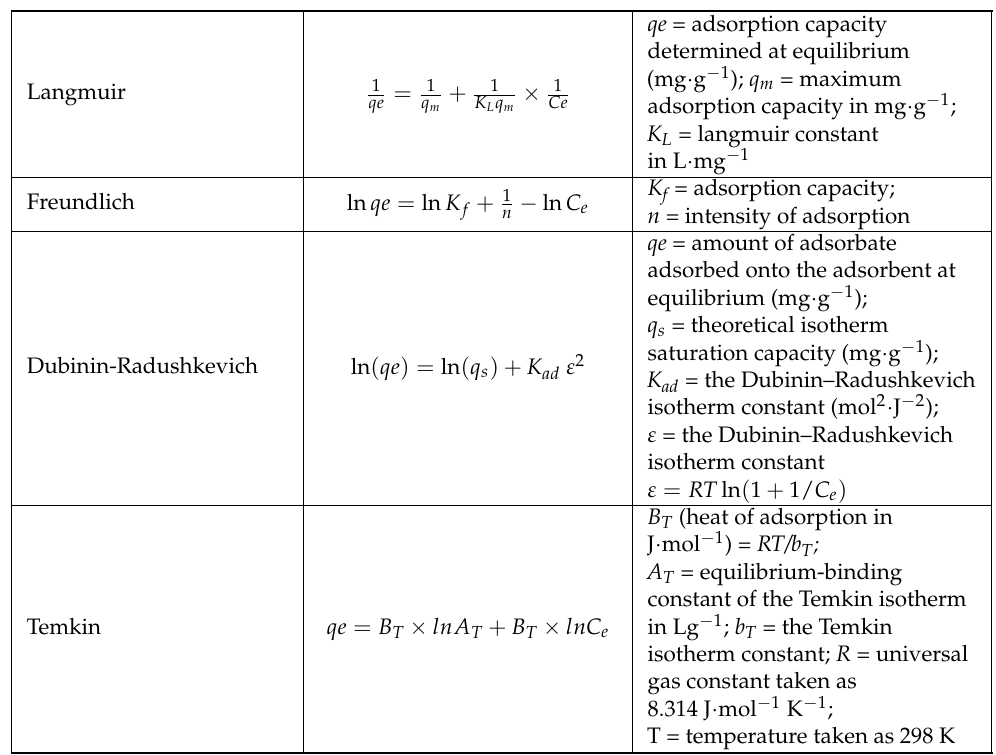
Table 5. Linearized models of isotherms. Own compilation based on literature data [110].